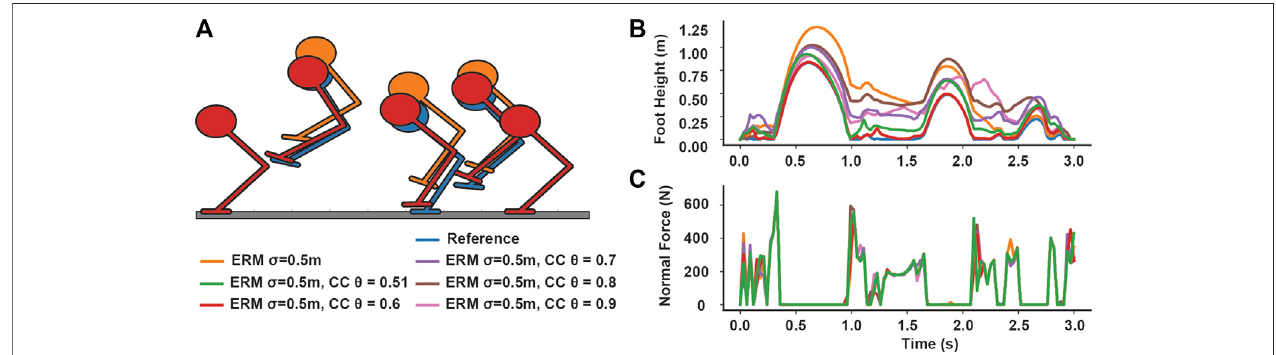
FIGURE 6 | Effect of including chance constraints on hopping under distance uncertainty. (A) Selected frames of the hopper trajectory comparing the reference, non-robusttrajectory,theERMonlytrajectory,and theERMwithchanceconstraintstrajectory.Onlythe θ (cid:2) 0.6caseisillustratedforbrevity. (B) Plannedfootheightsfor the hopper under high distanceuncertainty ( σ (cid:2) 0.5 m) fordifferentriskbounds, compared totheERM and reference trajectories, and (C) the associated normal ground reactionforces.TheERMcostallowsforcontactforcestobeappliedatnonzerodistances;however,astheriskboundsdecrease,thedistanceatwhichforcesare applied also decreases.